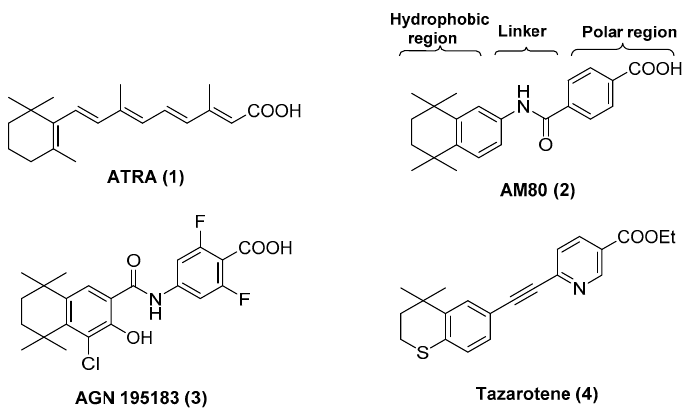
Figure 1. Chemical structures of ATRA ( 1 ) and representative aromatic RA derivatives ( 2 – 4 ).